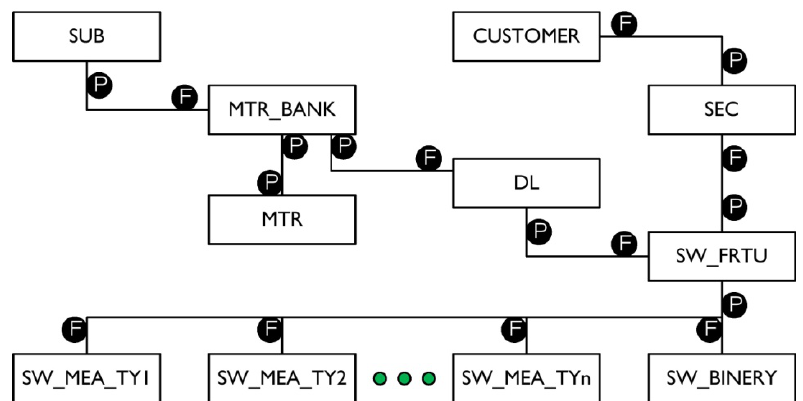
Figure 2. Off-line database structure of conventional